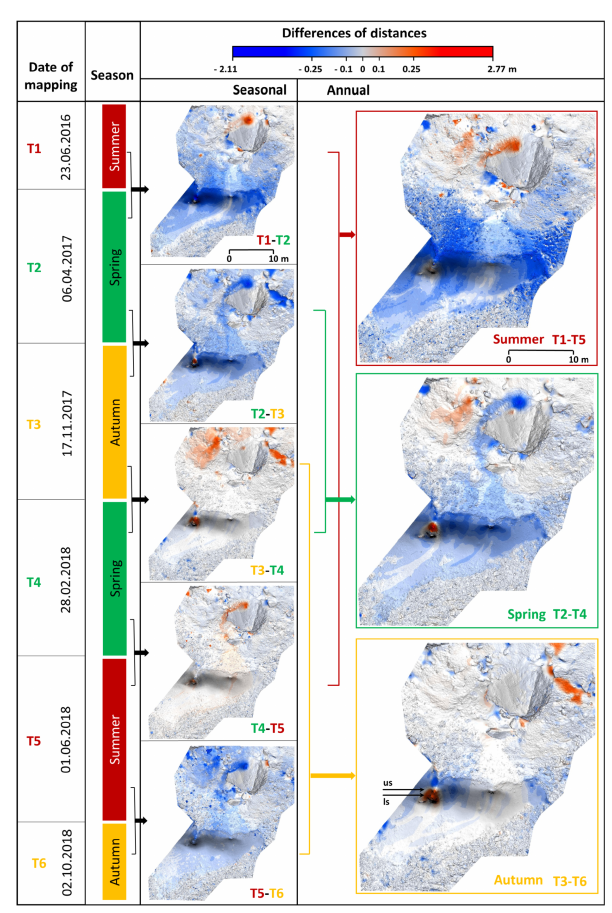
Figure 10. Differences of distances (DoD) between the individual cave floor surface models. Blue represents the decrease and red indi- cates the increase in the surface elevation. Arrows mark the position of the upper stalagmite (us) and lower stalagmite